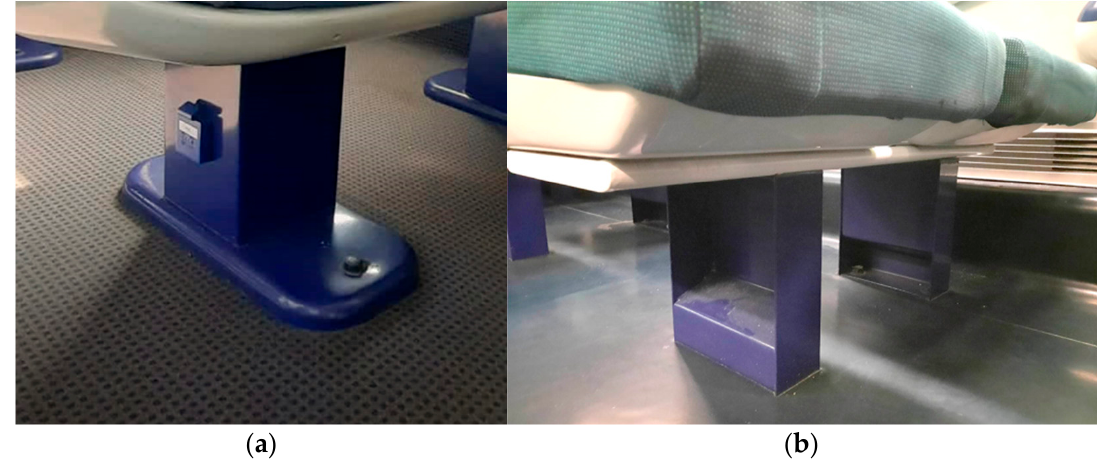
Figure 15. Seat metallic structural frame: ( a ) comfort seat structural frame; ( b ) standard seat structural frame.